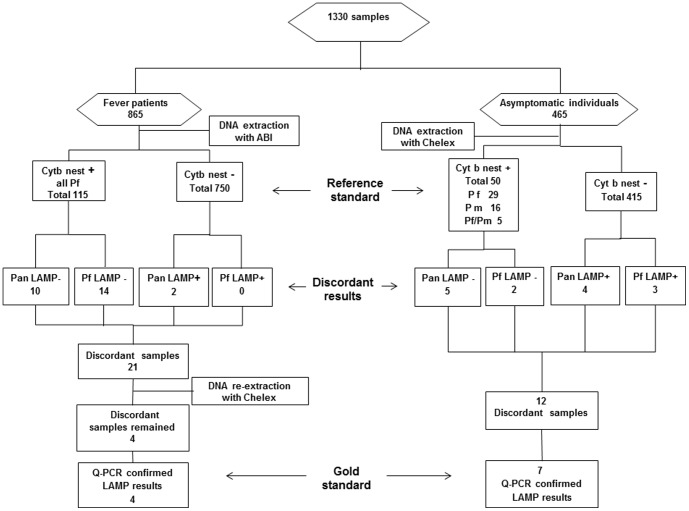
Flow chart of study. Reference standard = Cytochrome B nested PCR. Gold standard = Cytochrome B real-time PCR corrected nested PCR.